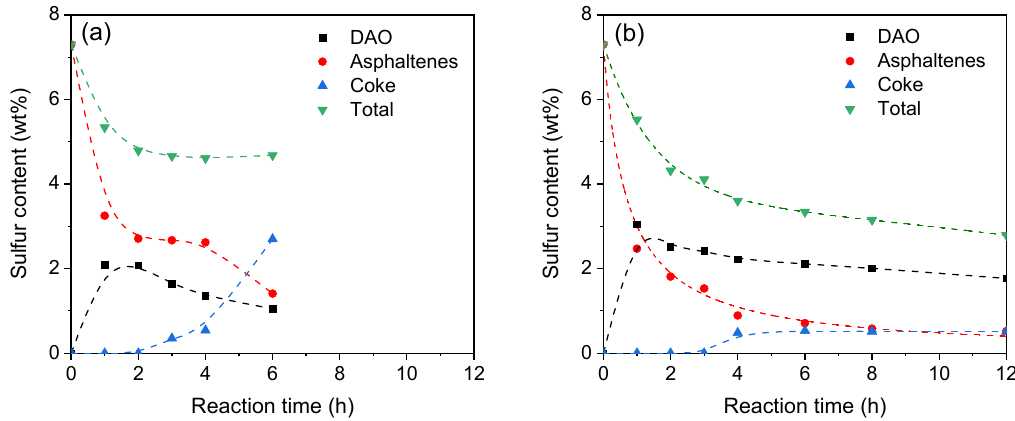
Figure 6. Sulfur content of DAO, remaining asphaltenes, coke, and total content after the catalytic hydrocracking of C 5 -Asp in ( a ) a batch and ( b ) semi-batch system. Reaction conditions: T = 410 °C, P H2 = 80 bar at 80 °C (batch) or 110 bar at 410 °C (semi-batch), and 1000 wppm of Mo from Mo-octoate in catalytic hydrocracking.